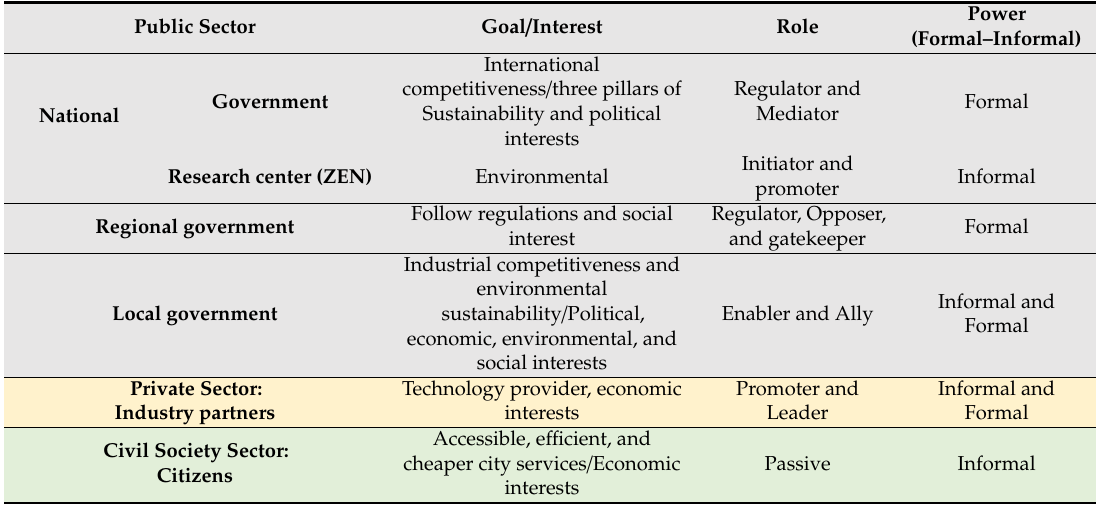
Table 2. Governance in the development of a smart city in Bergen.